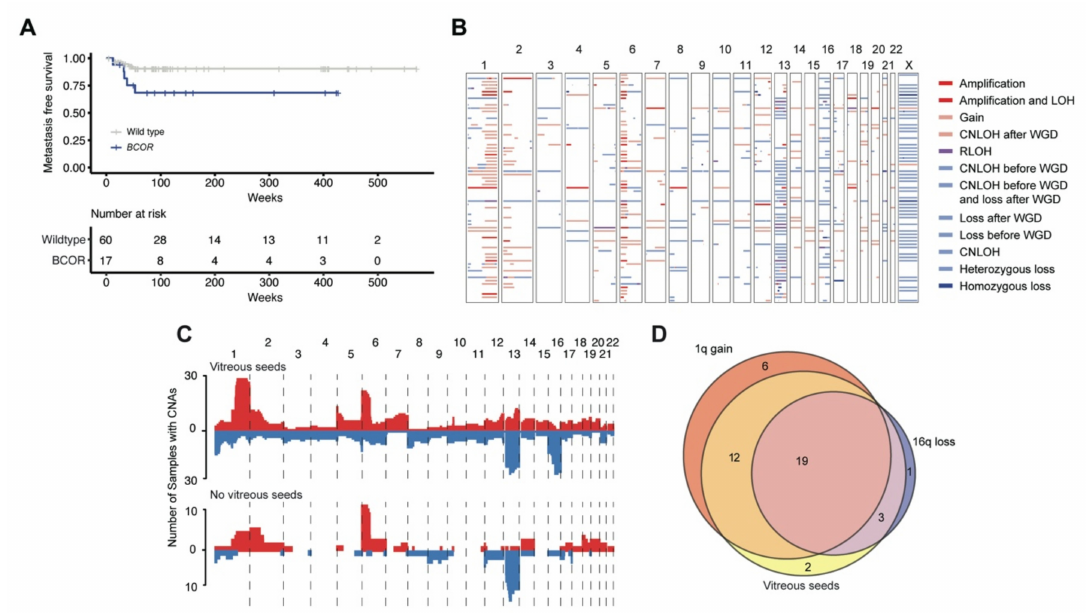
Figure 3. Correlation of genomic features with clinical characteristics. ( A ) Kaplan–Meier graph comparing metastases-free survival between specimens with a BCOR alteration and those without. BCOR is nominally correlated with metastases-free survival ( p -value = 0.03). ( B ) Copy number alterations of 69 eyes. Each row is an individual and each column is a different chromosome. White space shows where no gains or losses occur. Losses are shown in shades of blue while gains are shown in shades of red. ( C ) Plot showing the genomic copy number changes in individuals with vitreous seeds vs. without. The genome was binned into 100,000 bp regions and the height of each region shows how many specimens had a gain or loss in a given bin. Any gain is shown in red on the top of each plot while any sort of loss of heterozygosity is shown in blue at the bottom of each plot. There is a significant enrichment for 1q gain and 16q loss in individuals with vitreous seeds (BH-corrected p -value = 0.008 and 0.004, respectively). ( D ) Venn diagram of specimens that contain 1q gain, 16q loss and vitreous seeds. Limited to 43 samples that had annotation of vitreous seeds and FACETS fits to call alterations on 1q and